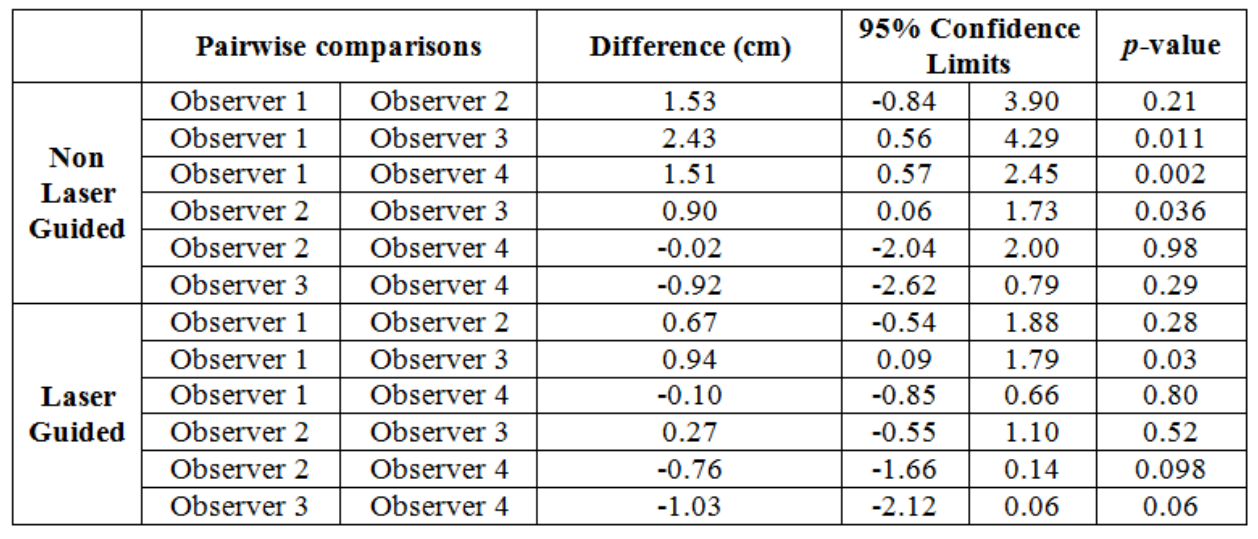
Table 3 : Phase 2 Live dog data - Pairwise comparisons between observers of difference in TC measurement